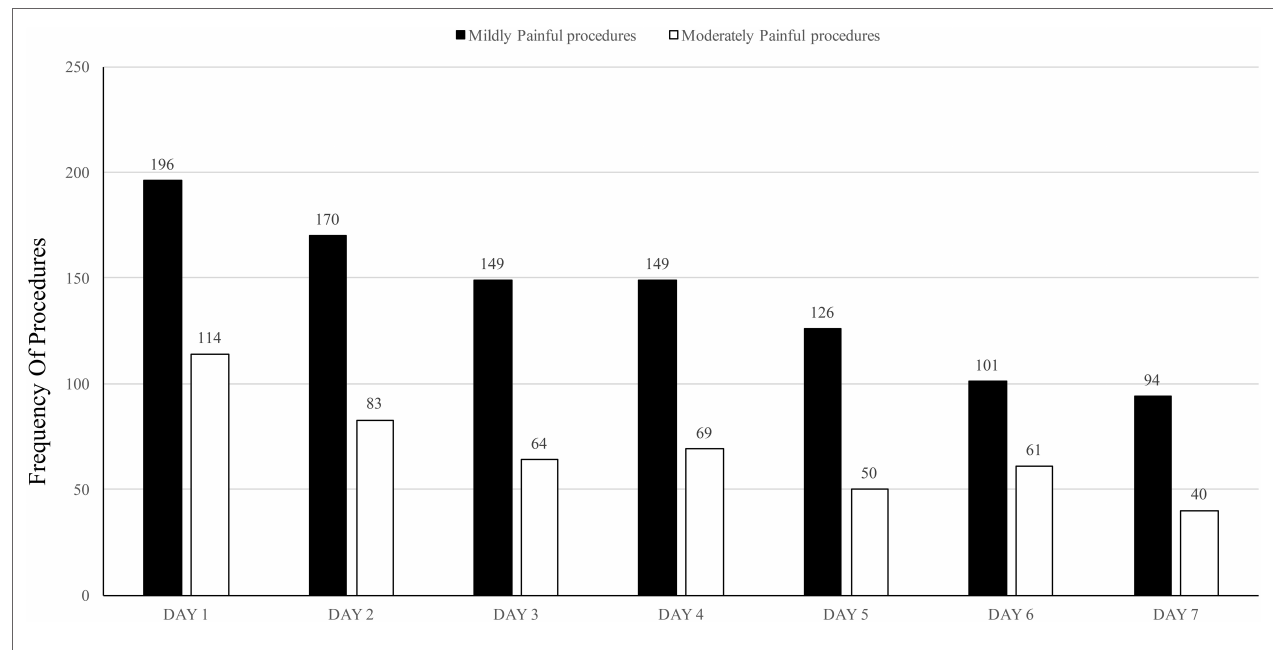
FigUre 1 | Distribution of painful procedures over the first 7 days of admission